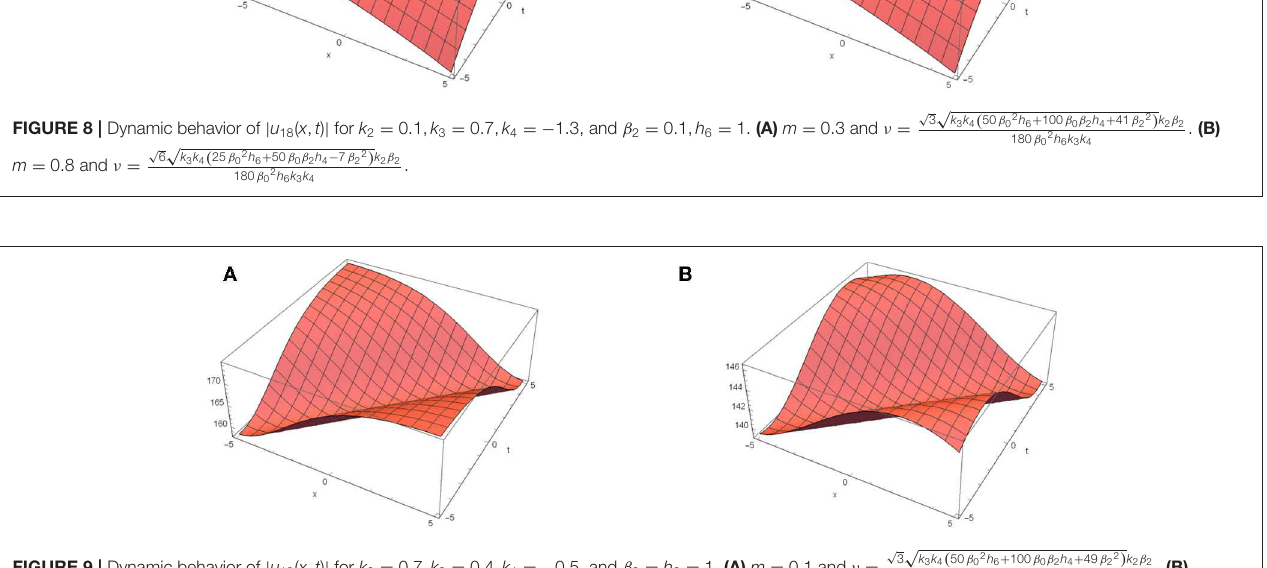
180 k 3 k 4 h 6 β 02